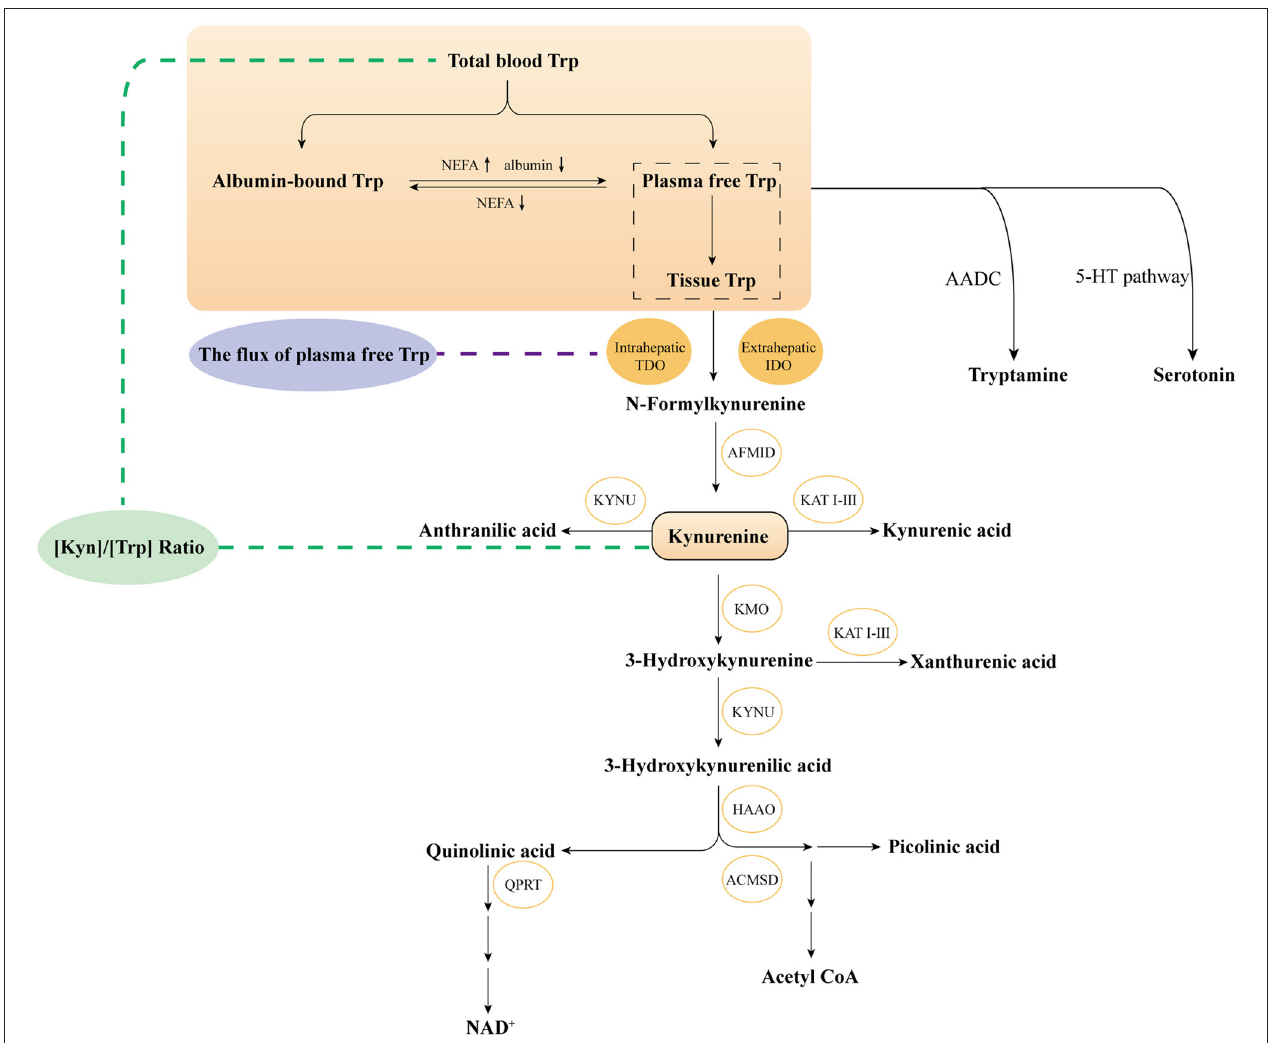
FIGURE 1 | Overviewthe KP of tryptophan metabolism. Trp, tryptophan; IDO, Indoleamine 2,3-dioxygenase; TDO, tryptophan 2,3-dioxygenase; AFMID, kynurenine formamidase; KYNU, kynureninase; KAT I–III, kynurenine amino transferases I–III; KMO, kynurenine 3-monooxygenase; HAAO,